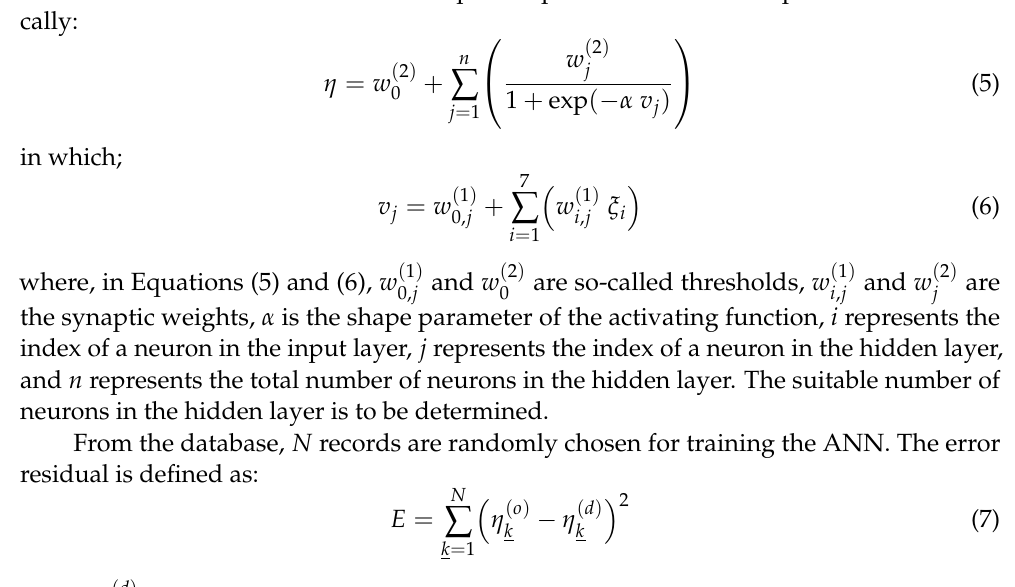
Figure 1. The input-output relation for predicting the compressive strength of concrete and the structure of the ANN model.